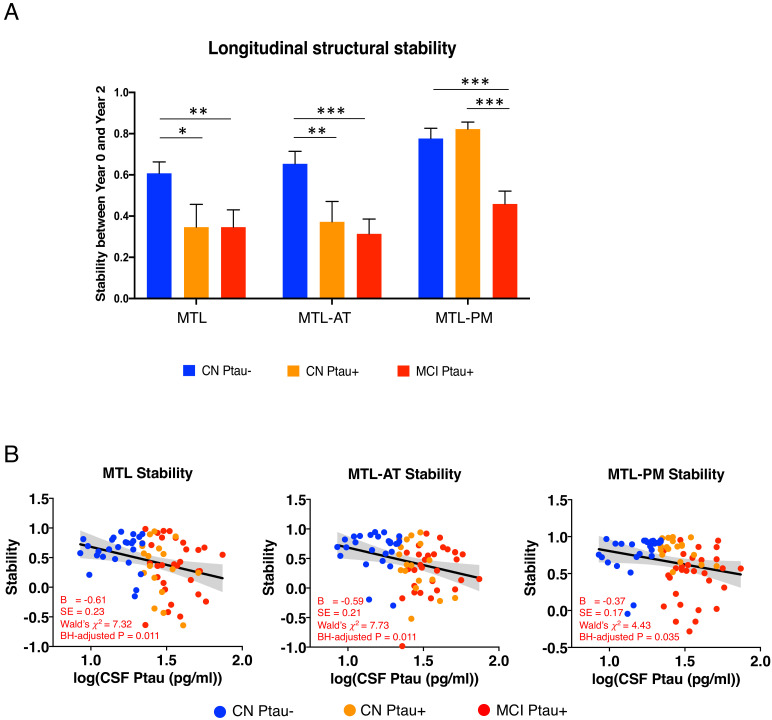
Relationship between baseline CSF Ptau and MTL structural stability.(A) Structural stability within MTL, MTL-AT, and MTL-PM for CN Ptau– (blue), CN Ptau+ (orange), and MCI Ptau+ (red) groups. Asterisk represents significant group comparison. *p < 0.05; **p < 0.01; ***p < 0.001. (B) Relationship of baseline CSF Ptau levels and structural stability within MTL, MTL-AT, and MTL-PM for the entire sample.
Figure 2—source data 1.Group comparisons.